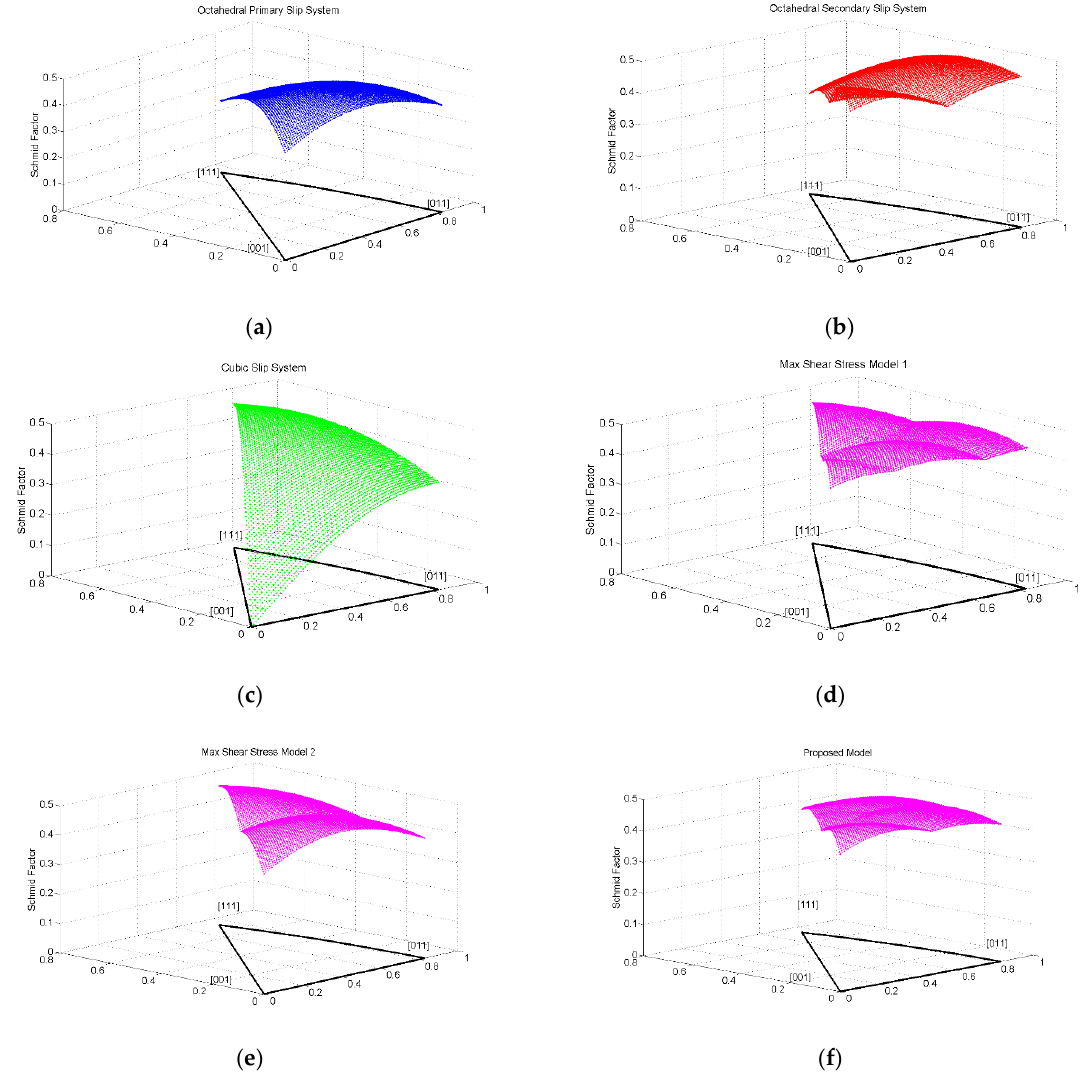
Figure 1. Schmid factors and modified factor: ( a ) primary octahedral slip system; ( b ) secondary octahedral slip system; ( c ) cubic slip system; ( d ) all three slip systems; ( e ) primary octahedral slip system and cubic system; and ( f ) modified factor.